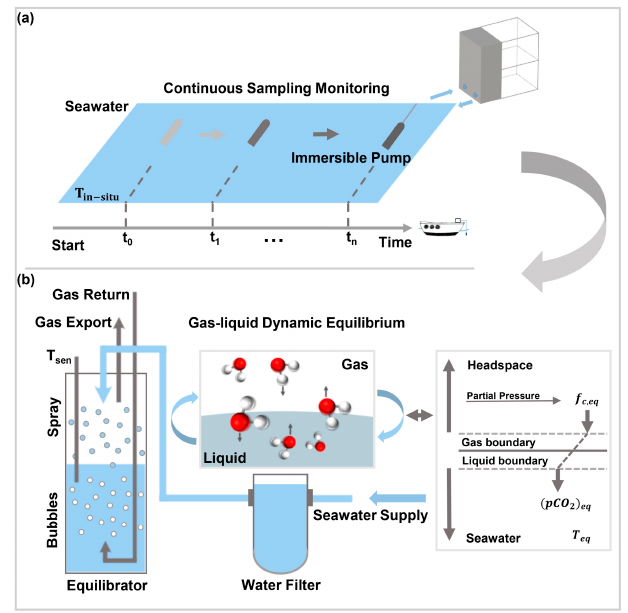
Figure 2. Schematic diagram of the sample extraction part of the system. ( a ) Continuous underway observation of the surface seawater. ( b ) Details of the headspace equilibrator and gas exchange model between the two gas-liquid phases. Gas Return: gas inlet for waste gas measured in the MPGC; Gas Export: gas outlet for equilibrium gas; T sen : temperature sensor of the water sample in the equilibrator.